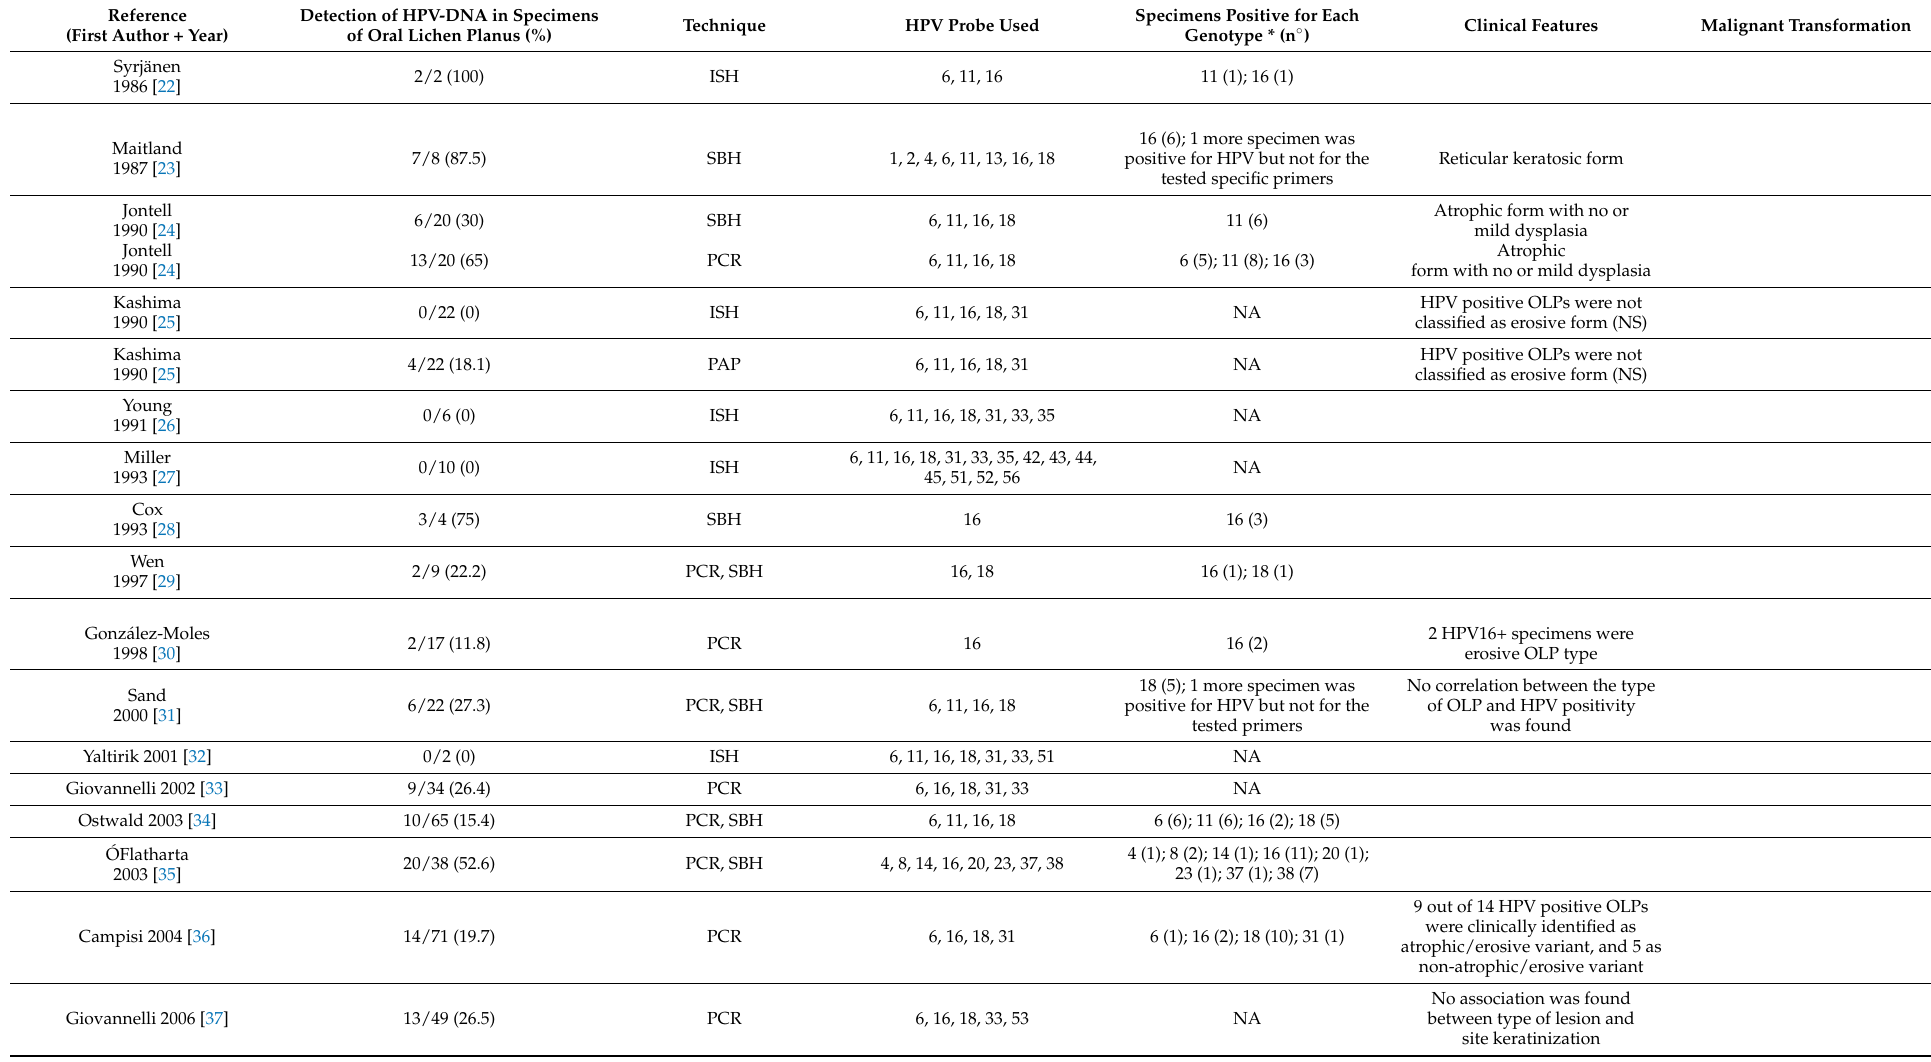
Table 2. Human papillomavirus (HPV) detection in OLP